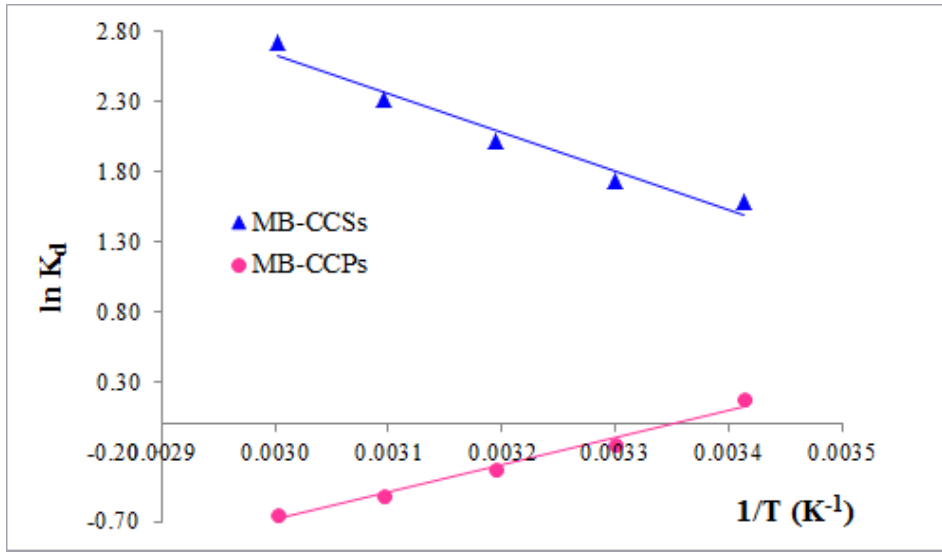
Figure 11. The plot of ln K d as a function of 1/T for the removal of MB dye by CCSs and CCPs.